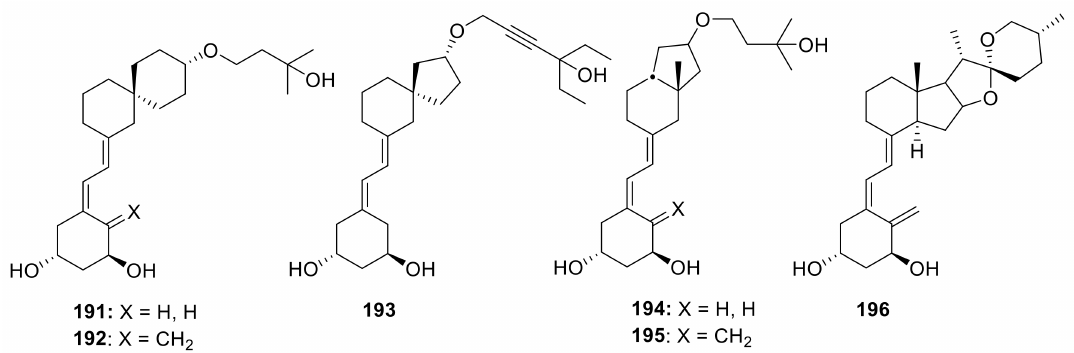
Figure 3. Unique examples of the modified D-ring moiety ( 191–196